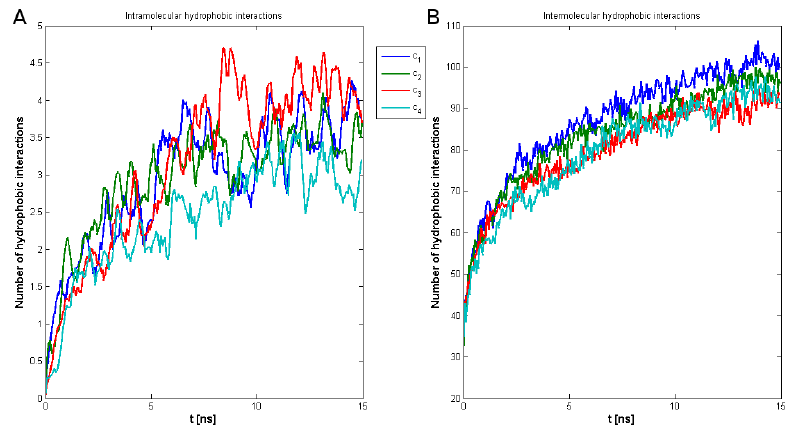
Figure 5. Total number of hydrophobic interactions for normal networks: ( A ) intra-molecular hydrophobic contacts are depicted; and ( B ) inter-molecular contacts.